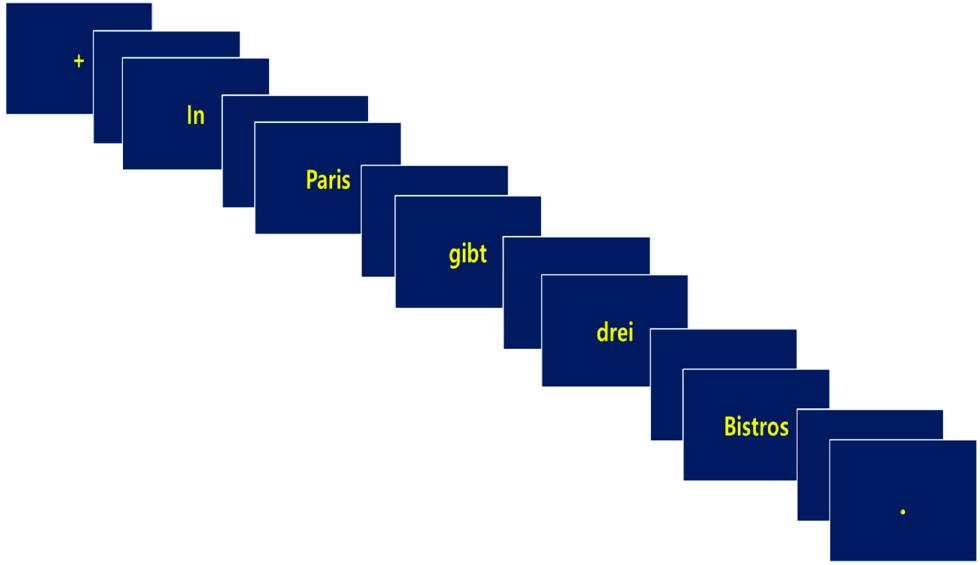
Figure 1. Schematic illustration of comprehension tasks.